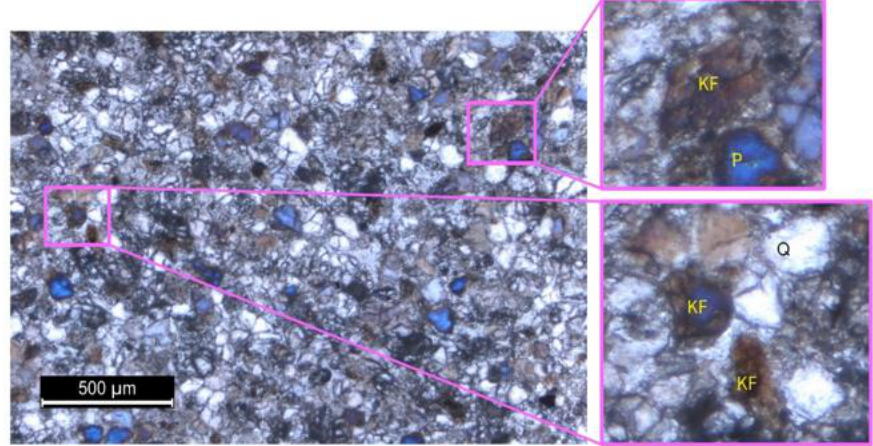
Figure 15. Textural and compositional features of L1-01. (Q) Quartz, (P) pore space, and (KF) kaolinite filling.